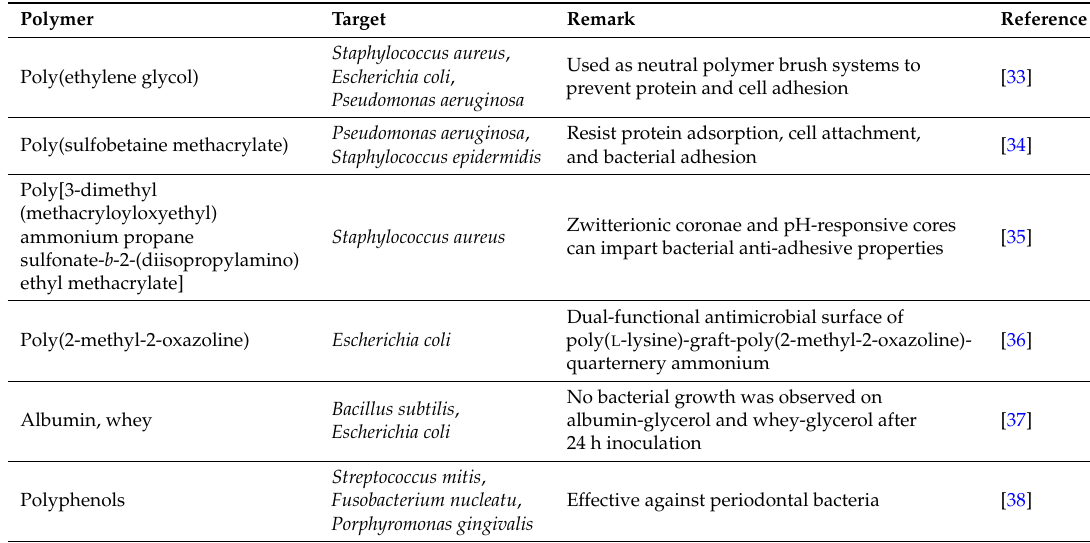
Figure 1. The schematic reaction mechanisms of passive and active action of the antimicrobial polymers. Table 2. Examples of passive polymers for antimicrobial applications.